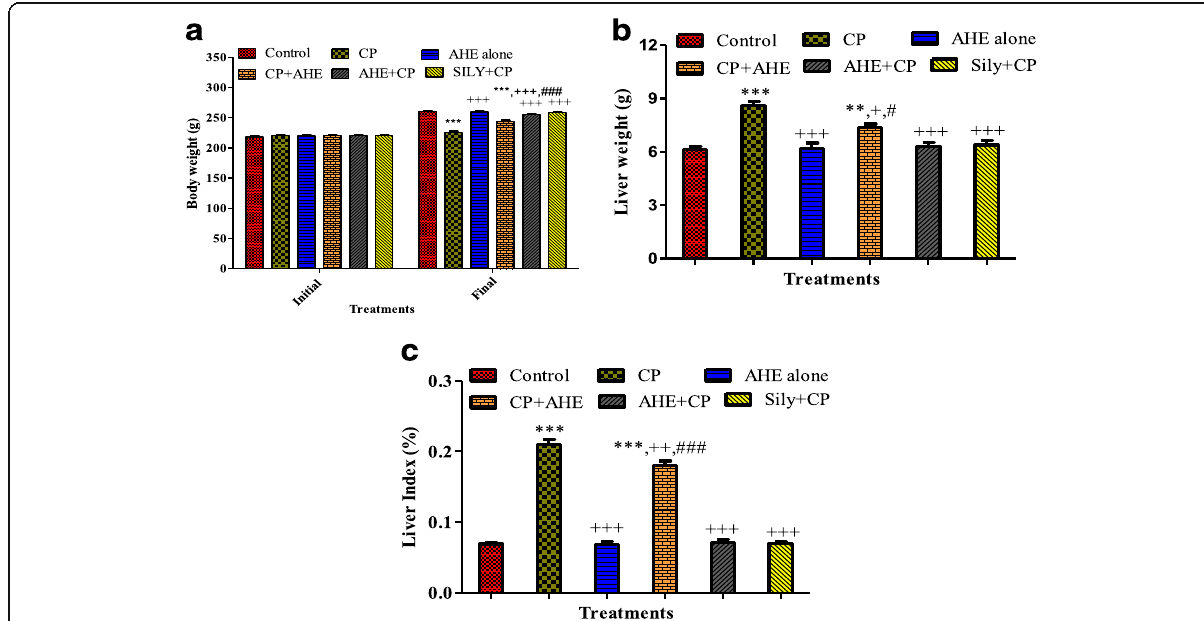
Fig. 1 Effect of the ethyl acetate extract of A. hydaspica (AHE) (400 mg/kg·bw) on a body weight, b liver weight and c liver index (%) in various treatment groups. Mean ± SE ( n = 6); statistical symbols in 1 a indicated significant difference in final vs initial body weight; in 1b and 1c *, **, *** indicated significance from the control group at p < 0.05, p < 0.01 and p < 0.0001 probability level, +, ++, +++ indicate significance from the CP group at p < 0.05, p < 0.01 and p < 0.0001 while ## indicate significance of AHE pre-treatment vs post treatment group at p < 0.01 probability level ( One way ANOVA followed by Tukey ’ s multiple comparison